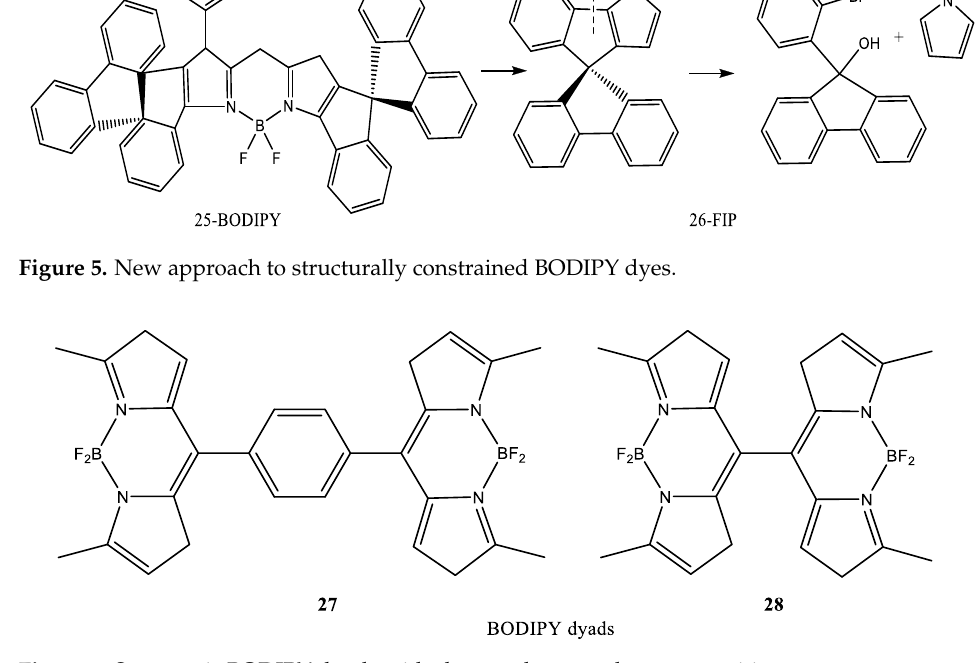
Figure 6. Symmetric BODIPY dyads with chromophores at the meso position.